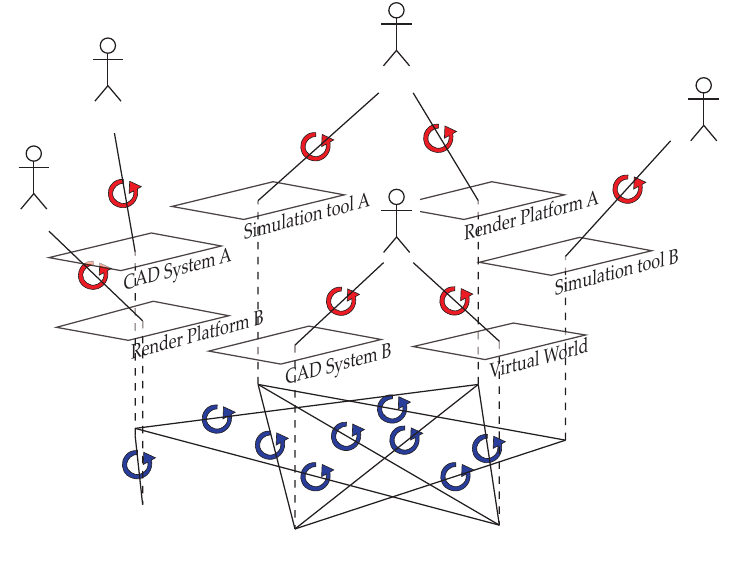
Figure 10. The issue of information flow, as outlined in Figure 1, can be subdivided in an interoperability issue among information systems (bottom - blue circular arrows) and a functionality mismatch issue between information systems and users (top - red circular arrows and user icons). The former issue is caused by interface points between information systems (blue circular arrows), whereas the latter is caused by interface points between information system and end user (red circular arrows). The information systems themselves are static environments displayed in the middle of the Figure (rectangular